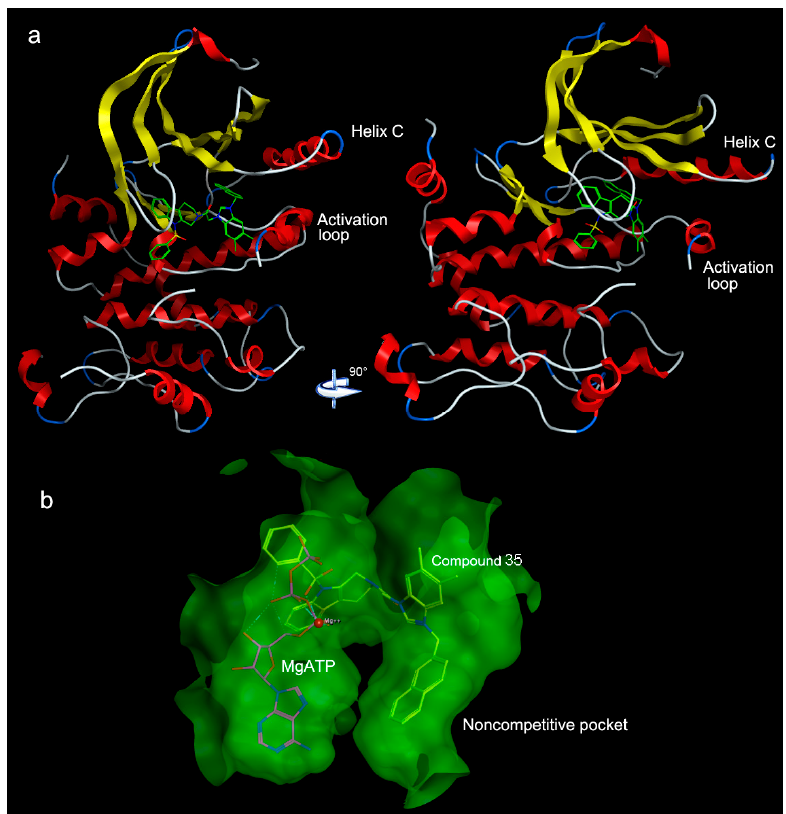
Figure 8. ( a ) Two views of the MEK1 protein kinase structure with the compound 36 ; ( b ) 3D Views of the ternary complex of mitogen-activated protein kinase 1 (MEK-1) bound to compound 36 and MgATP in a noncompetitive pocket.